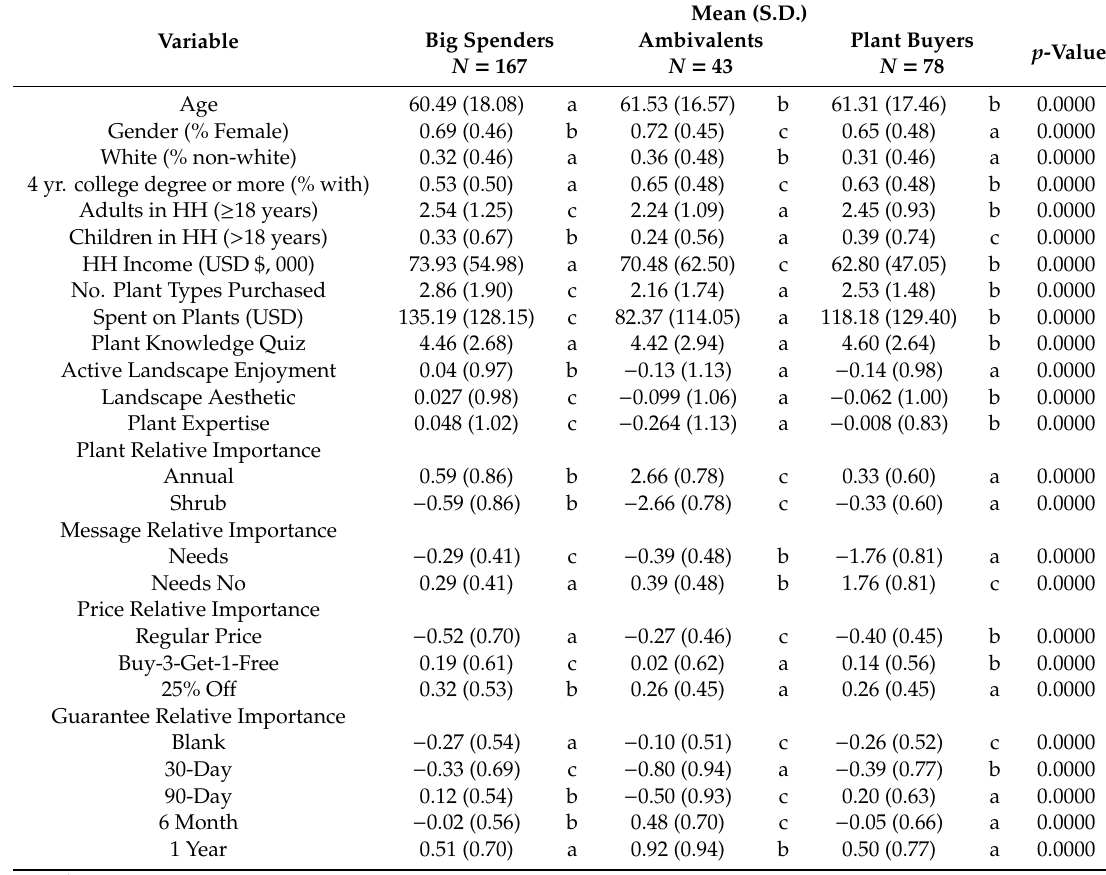
Table 6. Cluster proportions including PCA and part-worth utility values 1